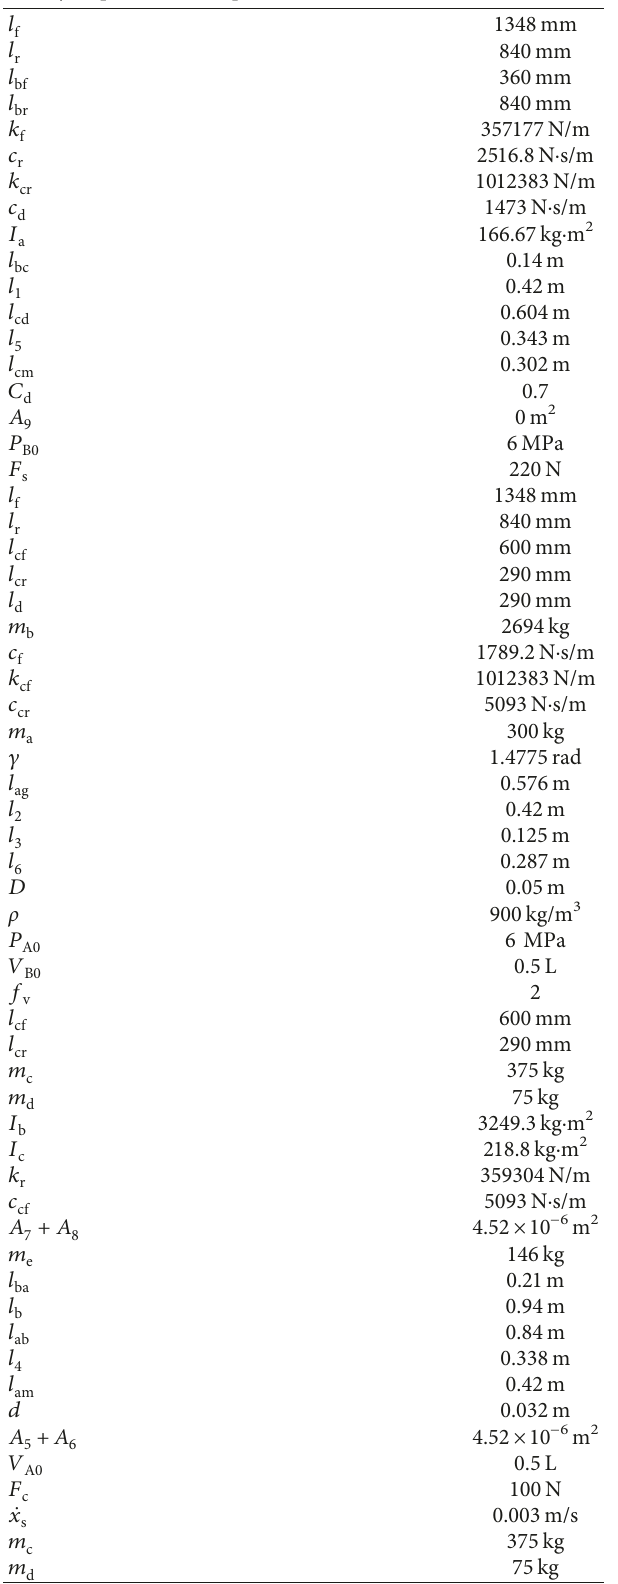
Table 1: Parameters of the wheeled tractor/implement with front axle hydropneumatic suspension.